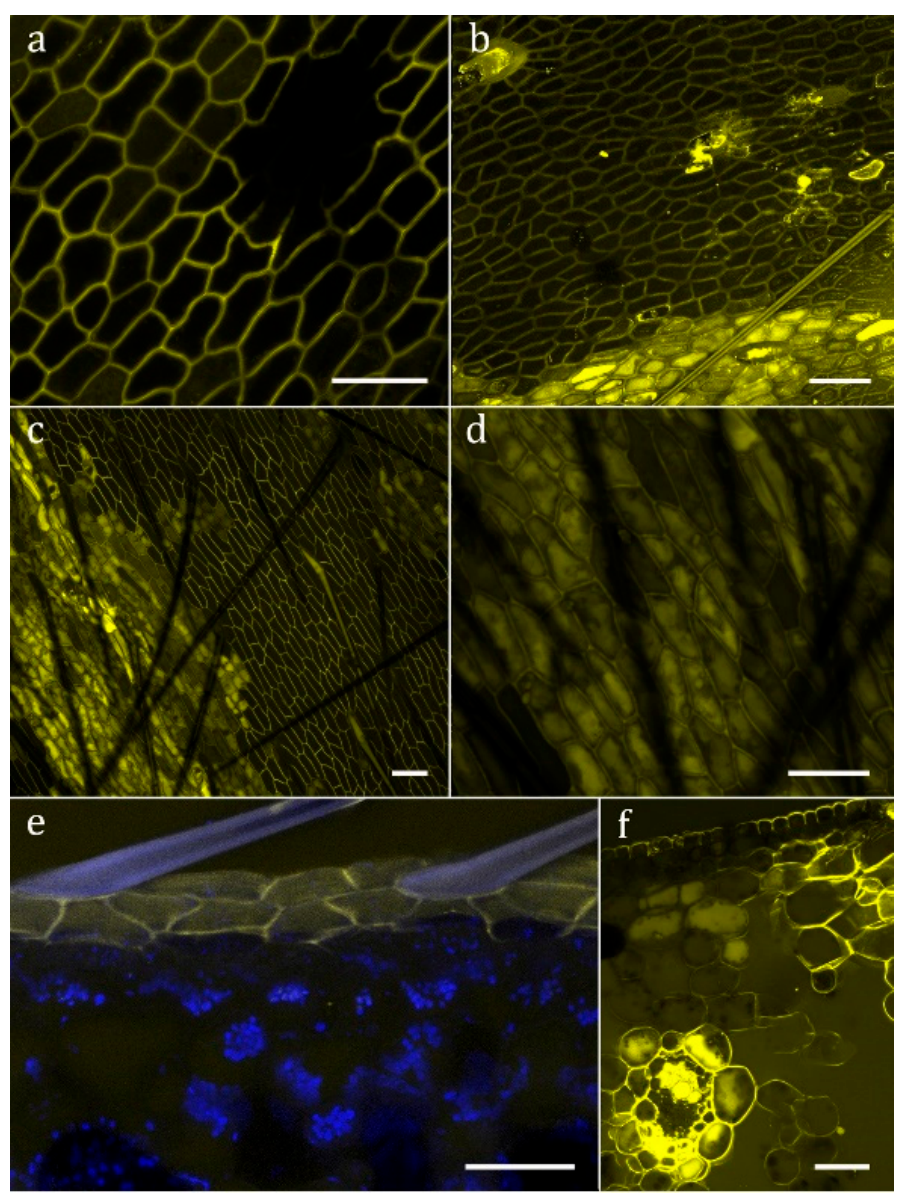
Figure 4. Uptake of the fluorescent protein FITC-BSA. The yellow color shows FITC-fluorescence in the detection wavelength 500–550 nm. ( a ) Sarracenia purpurea epidermal cells show no uptake; ( b ) Sarracenia minor ; ( c , d , f ) Sarracenia oreophila ; ( e ) Sarracenia leucophylla (the blue color shows autofluorescence of cuticle and chlorophyll, detection wavelength 626–672 nm). Scale bar: 50 µm.